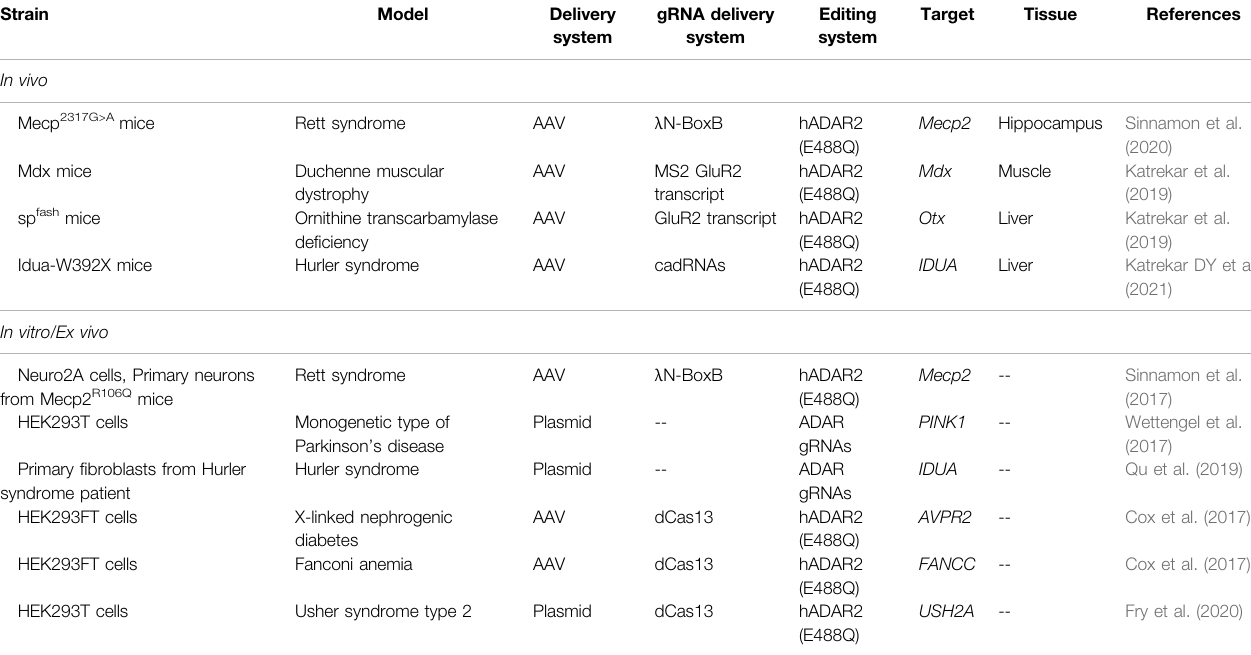
TABLE 1 | RNA editing for therapy of monogenic diseases in mouse